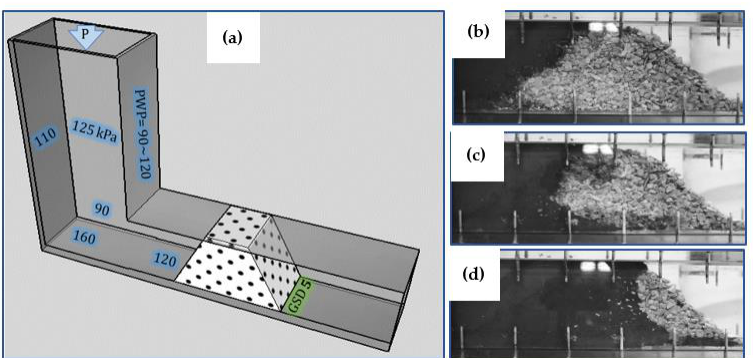
Figure 16. The failure mechanism of a barricade made of GSD #5: ( a ) the different pressure values in the model at failure, ( b ) the barricade before the failure, ( c ) the hand piston pushes water from the backfill into the pores of the barricade, and ( d ) the barricade after using the hand piston. Minerals 2020 , 10 , x FOR PEER REVIEW 18 of 23